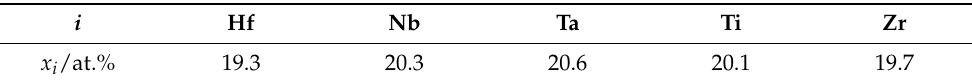
Table 1. Composition of a HfNbTaTiZr alloy determined by inductively coupled plasma optical emission spectrometry (ICP-OES). The standard deviation of the element concentration x i was below 0.2 at.%,